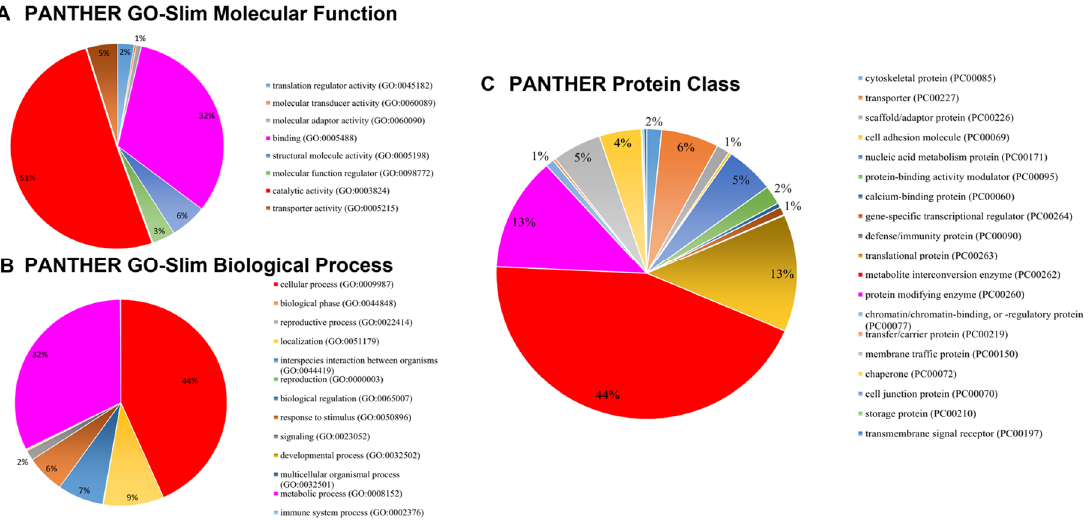
Figure 4. GO functional analysis and categorization of the JA tuber proteome in the current study using PANTHER tool. ( A ) Molecular function, ( B ) Biological process, ( C ) Protein class.